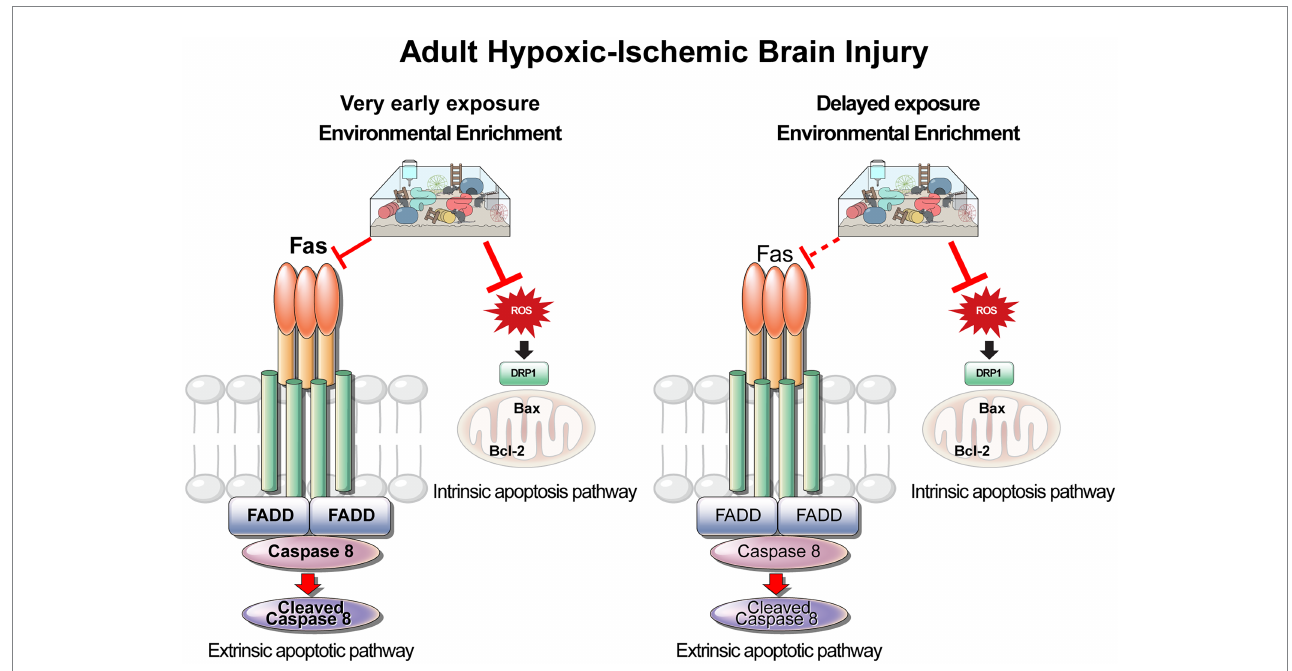
FIGURE 9 Schematic diagram of the extrinsic and intrinsic apoptosis pathways for very early and for delayed exposure to EE in the HI brain injury model. Solid lines indicate as activation and dashed arrows indicate as no activation. EE, environmental enrichment; HI,